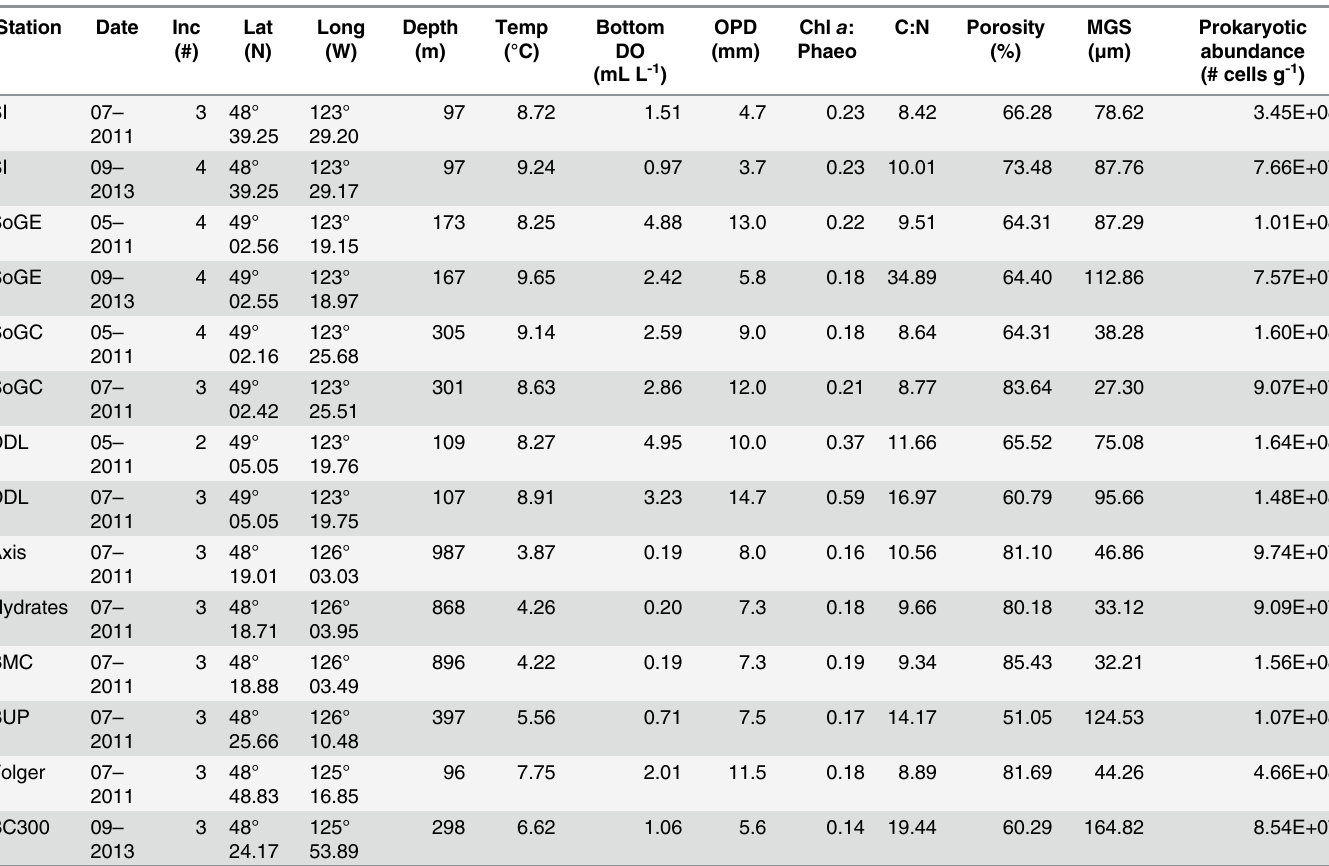
Table 1. Station names, sampling dates, number of incubations performed, locations and environmental variables measured. Bottom DO = Bottom water dissolved oxygen concentration; OPD = Oxygen penetration depth; Chl a :Phaeo = Chlorophyll- a to phaeopigments ratio; C:N = Carbon-to-nitrogen ratio; MGS = Sediment mean grain